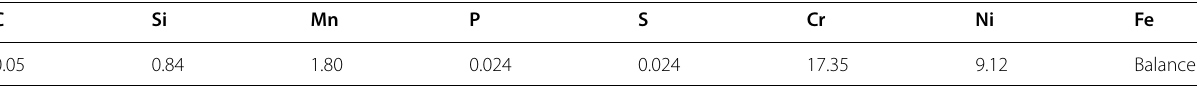
Table 1 Chemical compositions (wt.%) of AISI 304 stainless steel C Si